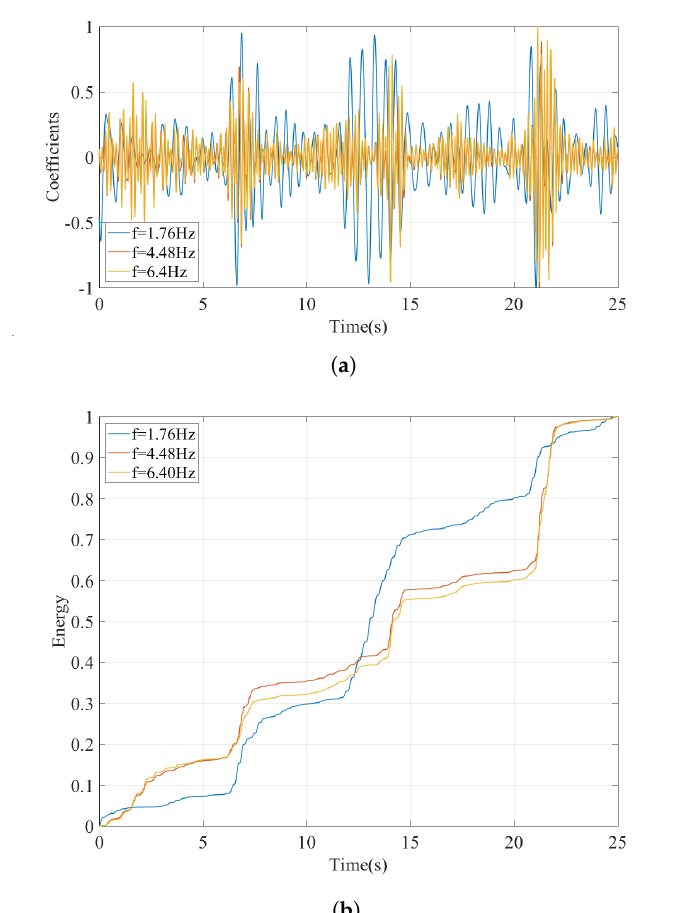
Figure 17. ( a ) Coefficient time history and ( b ) time evolution of energy at different frequencies computed using CWT for V = 20 km/h for track irregularity profile B.